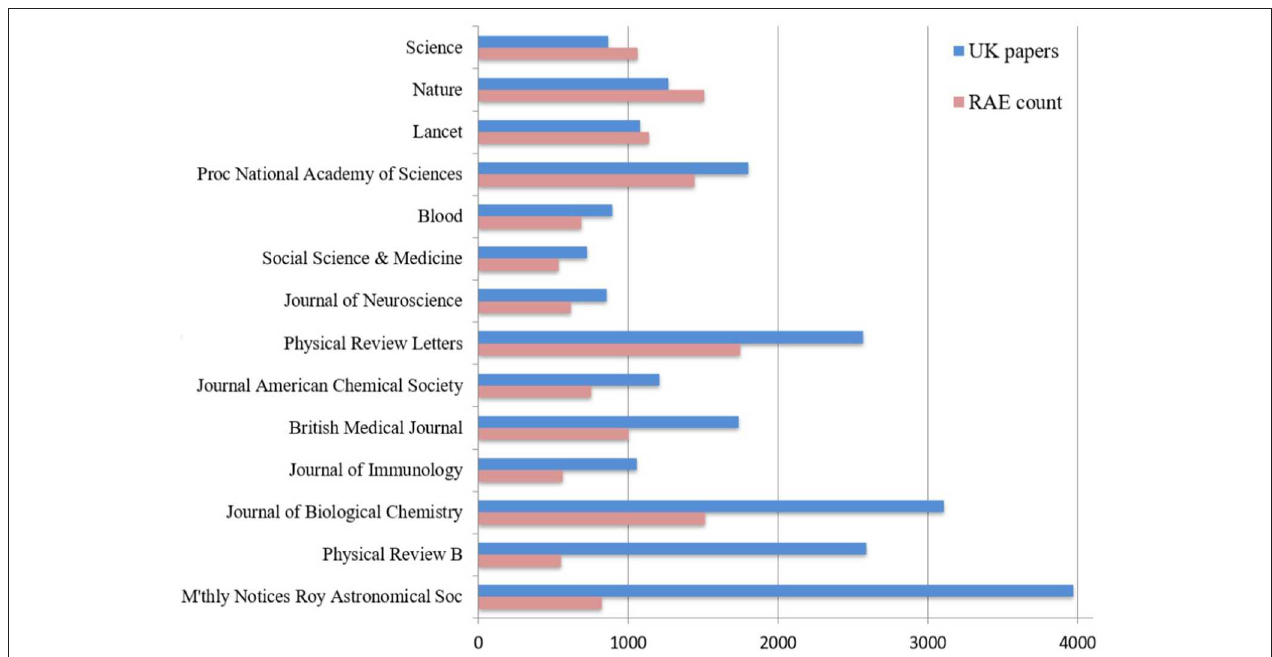
FIGURE 2 | Frequency of articles in a range of journals with a high citation impact factor. “UK papers” is the number of articles with at least one UK author-address during the period 2001–2007 (the census period of RAE2008). “RAE count” is the number of articles submitted to the Research Assessment Exercise in 2008.